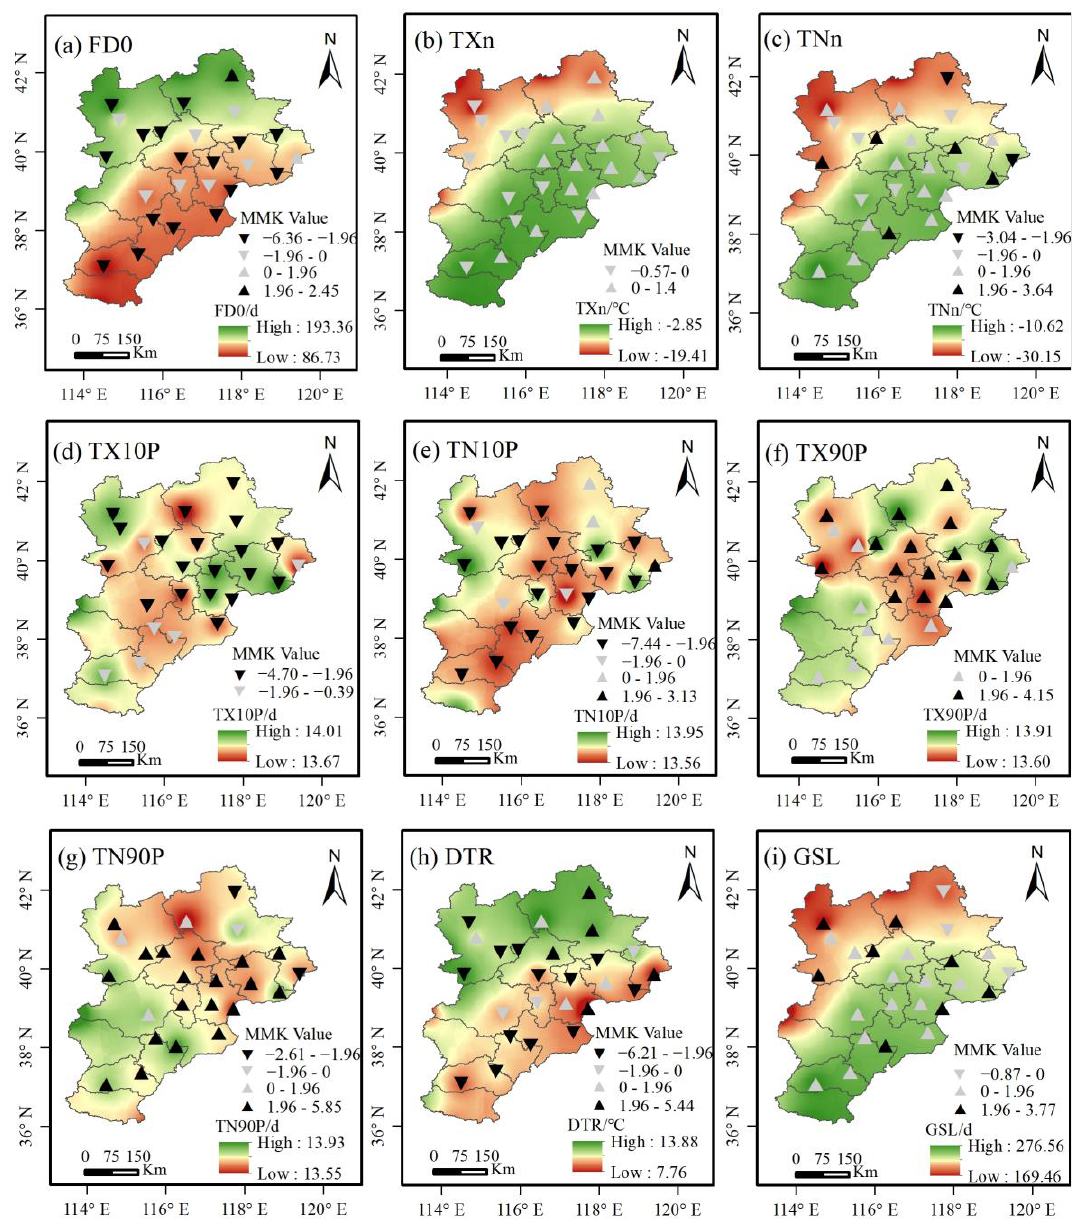
Figure 5. Spatial distribution of averaged extreme temperature indices and trends in Beijing – Tian- jin – Hebei during 1980 – 2019 (|MMK| >1.96 means passing 95% confidence level); (a) FD0; (b) TXn; (c) TNn; (d) TX10P; (e) TN10P; (f) TX90P; (g) TN90P; (h) DTR; (i) GSL.